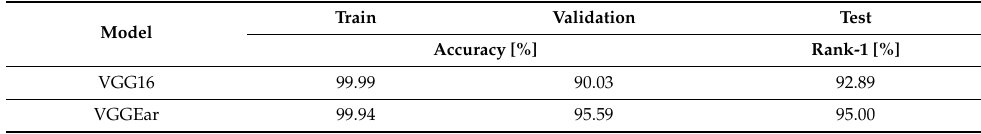
Table 6. Overall performance of the two fine-tuned